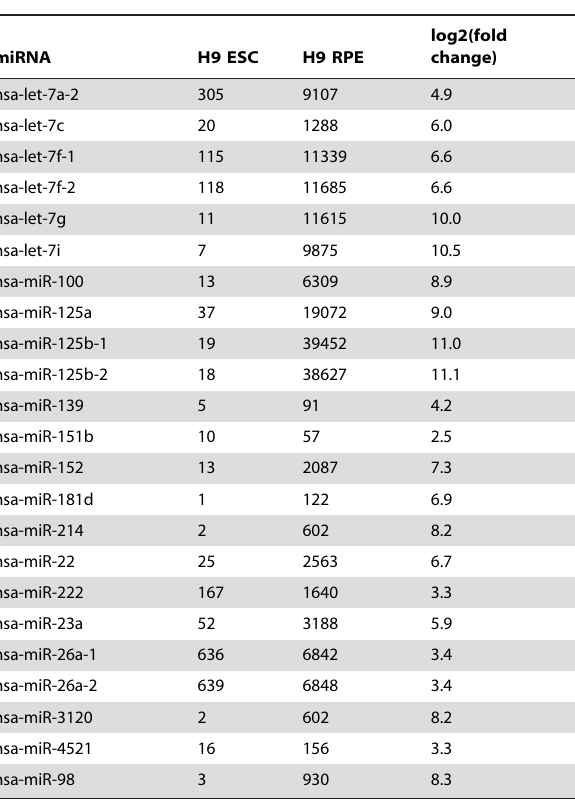
Table 2. Upregulated miRNAs in RPE during ESC